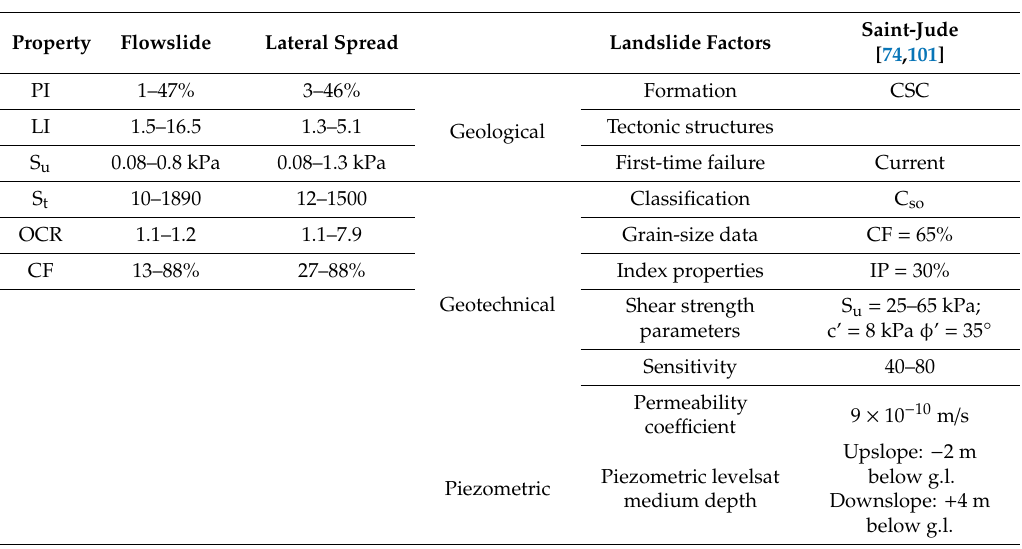
Table 4. Class 2 (Figure 11): summary of the geotechnical parameters ( a ) of the quick clays of some Canadian landslides [102] and landslide factors ( b ) of the Saint Jude flowslide-spread [74,101]; Key: PI—average values of the plastic index, LI—minimum values of the liquidity index, S u —minimum values of the undrained shear strength measured with the Swedish cone, S t —sensitivity measured with the Swedish cone, OCR—overconsolidation ratio, CF—clay